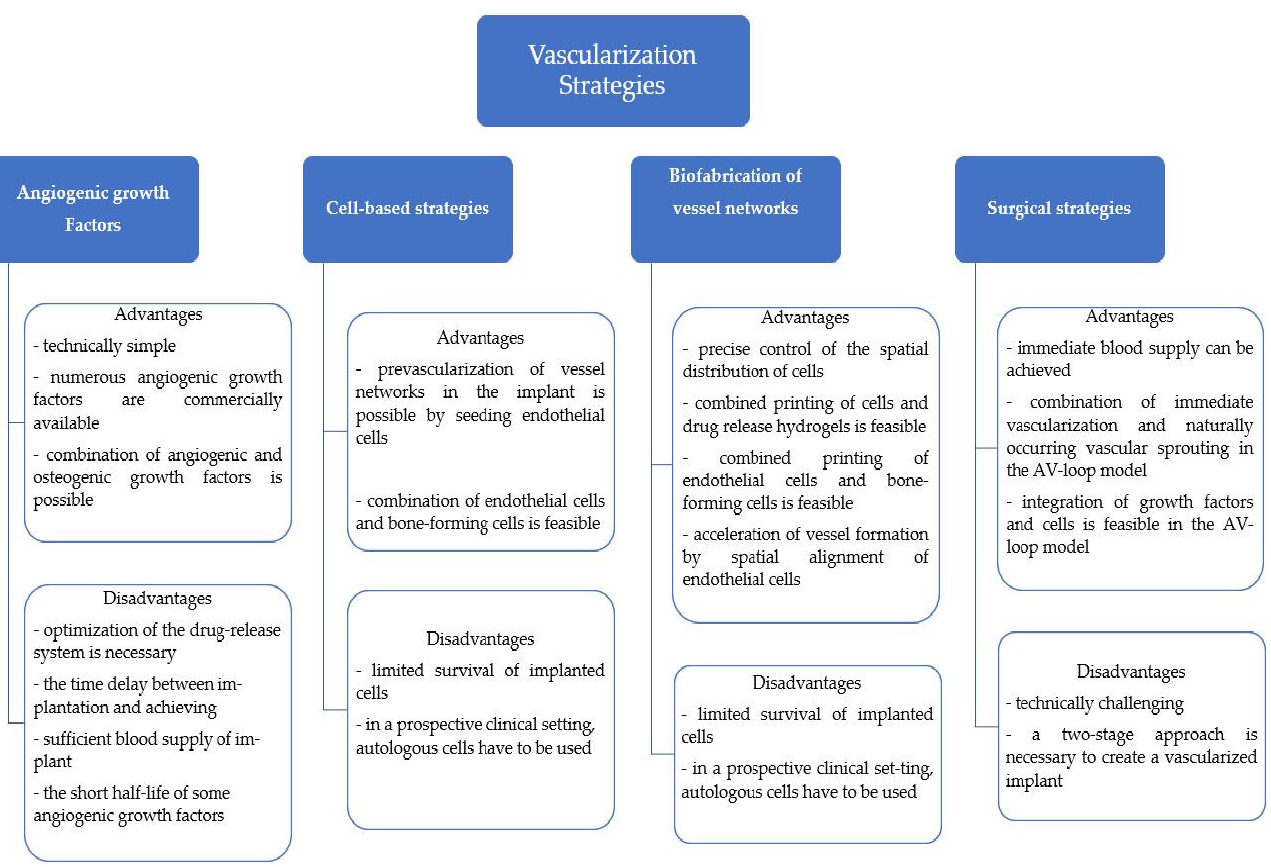
Figure 1. Advantages and disadvantages of vascularization strategies. Created based on information from [7].